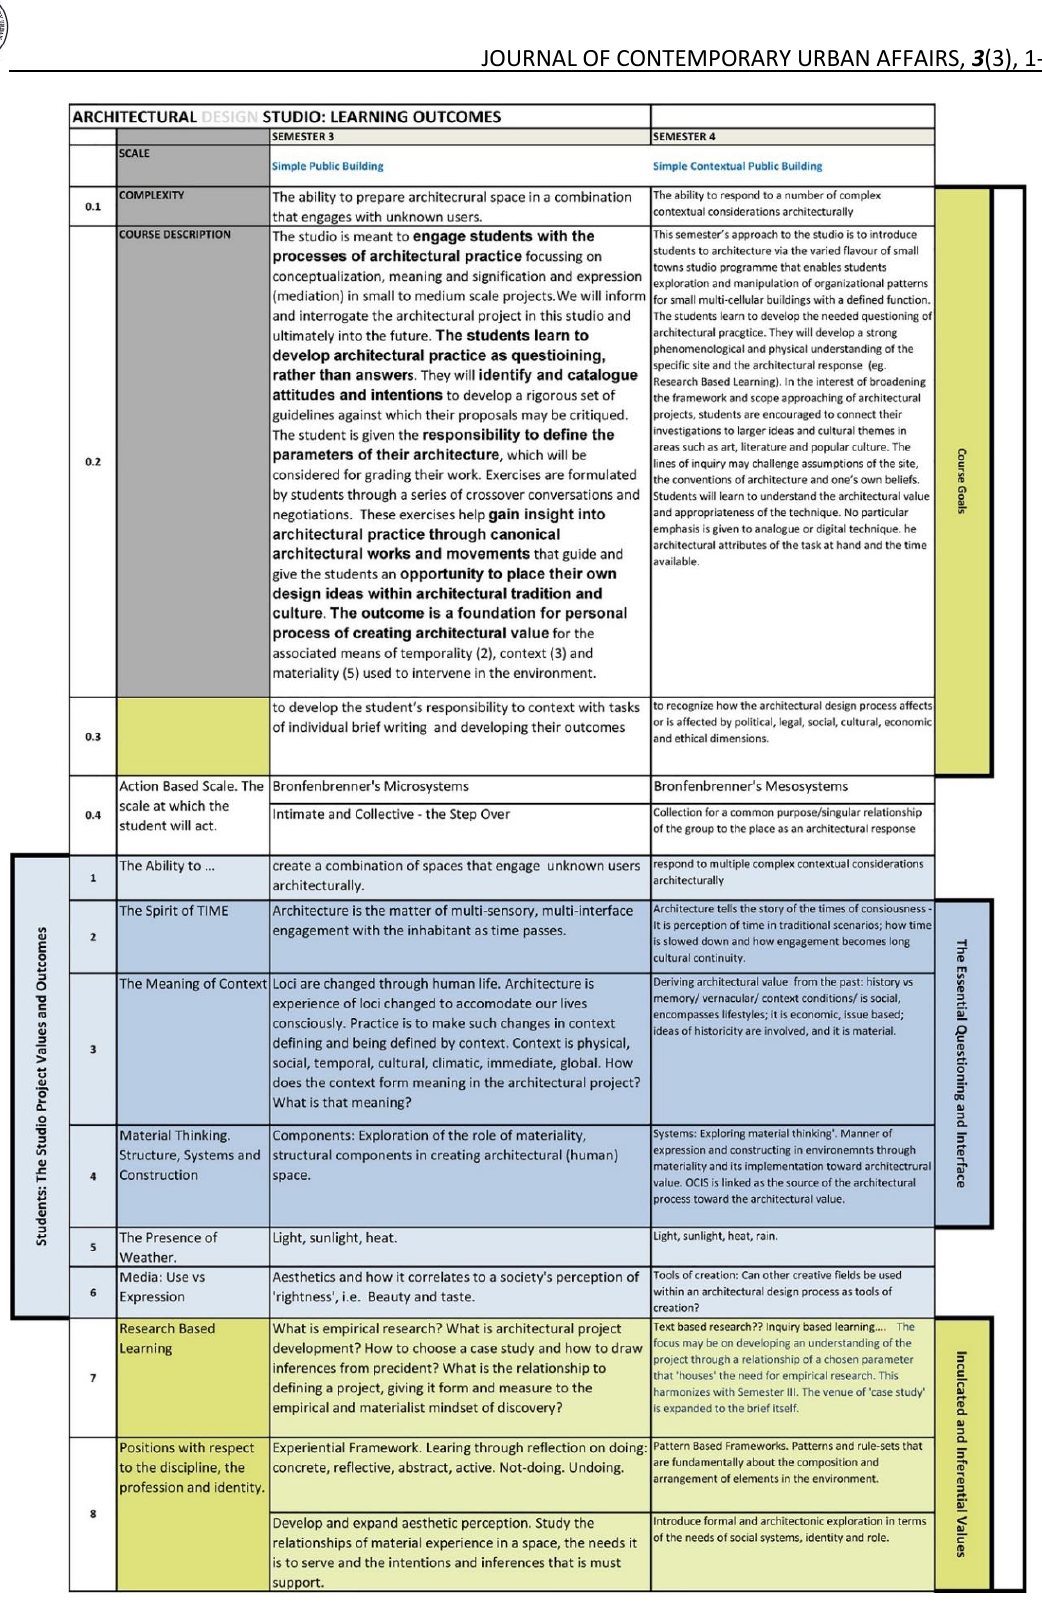
Figure 2. The Semester III and IV section of the Sushant School of Architecture curriculum: the Architectural Studio Learning Outcomes. Semester III has been modified by the author and the peripheral structure based on the remit of the students